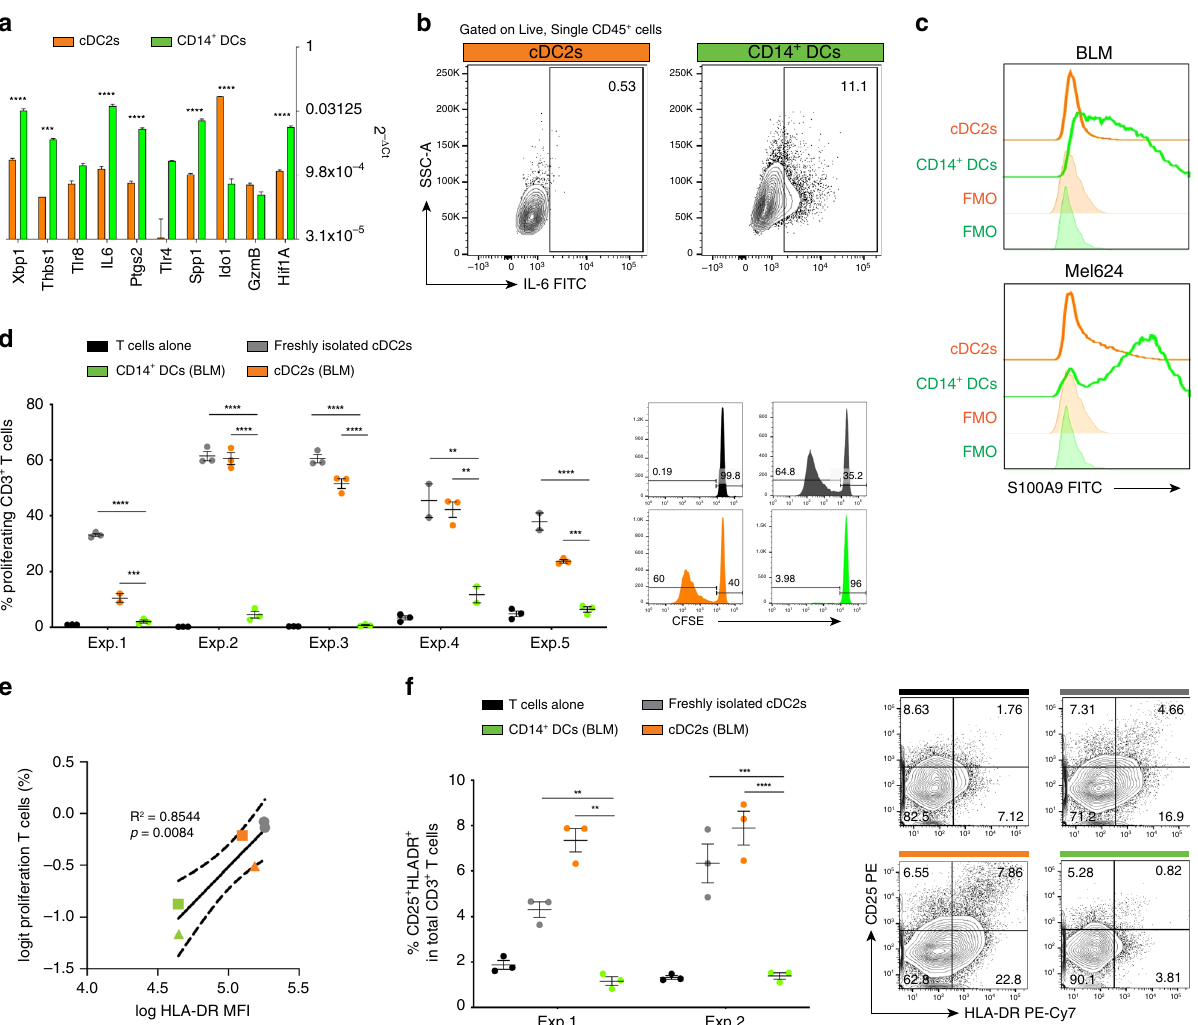
Fig. 6 Functional characterization of cDC2s and CD14 + DCs isolated from human OMC. a Two days after total cDC2s injection, BLM-OMCs were digested and CD1c + CD14 − (cDC2s) and CD1c + CD14 + (CD14 + DCs) subsets FAC-sorted for RNA extraction and molecular characterization by qRT-PCR. Gene expression levels (2 − Δ Ct ) for the indicated genes in cDC2s and CD14 + DCs. Reported values for each gene are the means of n = 3 biological replicates (mean ± SEM; two-way ANOVA and Sidak ’ s multiple comparisons test). ACTB was used as internal reference. Colour legends indicate: cDC2s (orange), CD14 + DCs (green). b IL-6 production assayed by intracellular cytokine staining in BLM-educated cDC2s, upon stimulation with LPS (1 μ g/mL) for 6 h. cDC2s and CD14 + DCs were identi fi ed and gated based on CD1c and CD14 expression in CD45 + live single cells. Representative dot plots are shown. Numbers indicate the percentage of gated cells. c Intracellular protein expression of S100A9 in tumour-educated cDC2s and CD14 + DCs. Representative GeoMFI histograms for BLM and Mel624 are shown. d Proliferation of allogeneic CD3 + T cells 5 days after co-culture with FAC-sorted cDC2s and CD14 + DCs. Scattered dot plots ( fi ve independent experiments, in triplicate (Exps. 1 – 2-3) and duplicate (Exps. 4-5) samples; mean ± SEM; one- way analysis of variance (ANOVA) and Tukey ’ s multiple comparisons tests). Representative CFSE histogram plots from Exp. 2 are shown; numbers indicate the percentage of gated cells. e Biplot of HLA-DR expression and induced allogeneic T-cell proliferation in Exps. 4 and 5. Correlation assessed by linear regression. f Autologous T cells were co-cultured with cDC2s and CD14 + DCs for 5 days and then stained for HLA-DR, CD25, CD3, CD8 and live/ dead marker. Percentage of activated CD25 + HLA-DR + cells in total CD3 + T cells is reported. Scattered dot plots (two independent experiments, in triplicate samples (mean± SEM; one-way analysis of variance (ANOVA) and Tukey ’ s multiple comparisons tests). Representative dot plots from Exp. 1 are shown. Statistical signi fi cance was annotated as follows: ** p < 0.01, *** p < 0.001, **** p < 0.0001. Source data are provided as a Source data fi